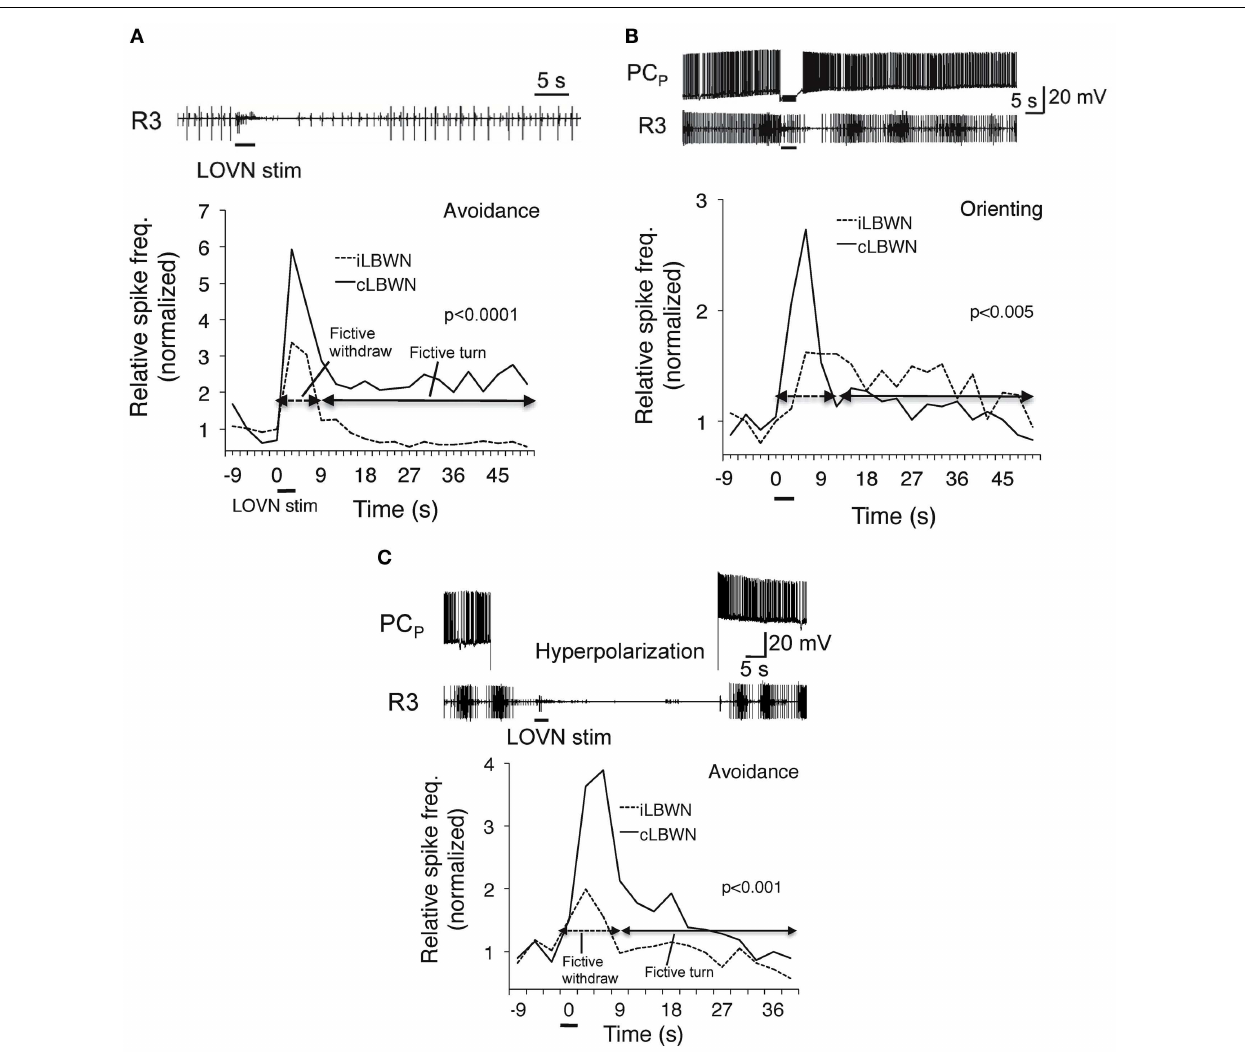
(PCp; Gillette et al., 1982) whose firing induced rhythmic bursting in a feeding nerve ( R 3). Hyperpolarization of PCN (C) suppressed fictive feeding and restored avoidance. From Hirayama and Gillette